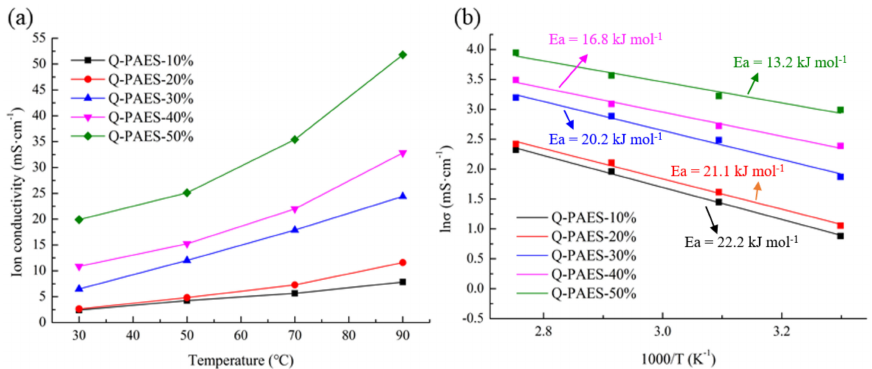
Figure 8. ( a ) Ion conductivity of Q-PAES membranes and ( b ) Arrhenius plot of Q-PAES membranes at diversified temperatures with 100% RH.